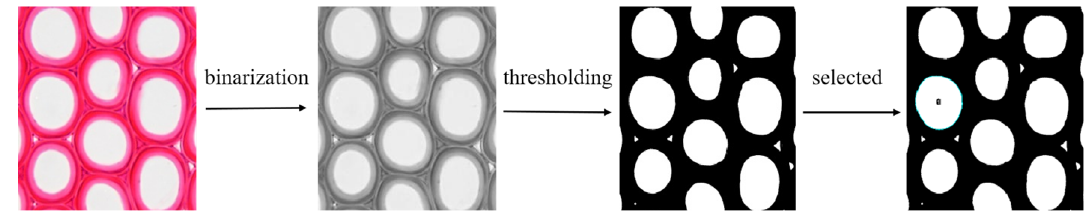
Figure 2. Schematic diagram for calculating the roundness value of tracheid cross-sections.